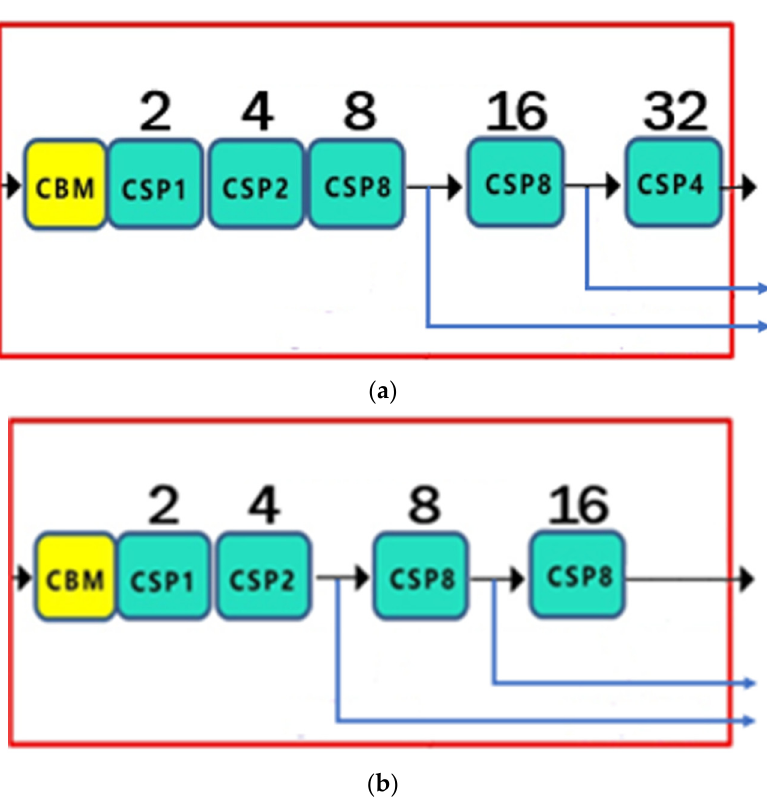
Figure 7. Architecture of ( a ) traditional YOLOv4 and ( b ) the proposed YOLOv4-s .